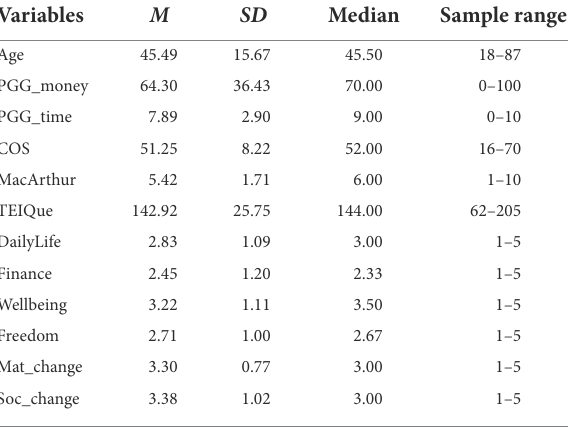
TABLE 1 Descriptive statistics of the key